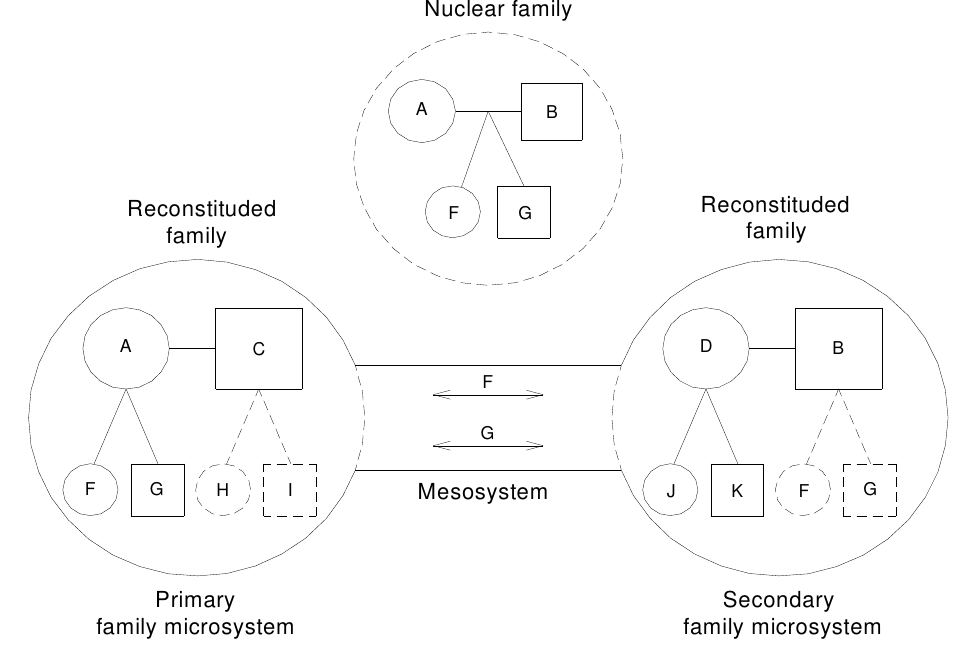
Figure 5 The primary and secondary family micro systems of the children of divorced Spouses A en B, where both spouses remarried (Ebersohn,